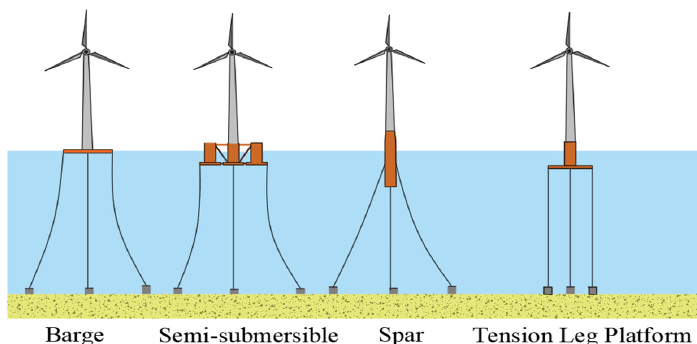
Figure 5. Schematic diagram of floating offshore wind turbine.